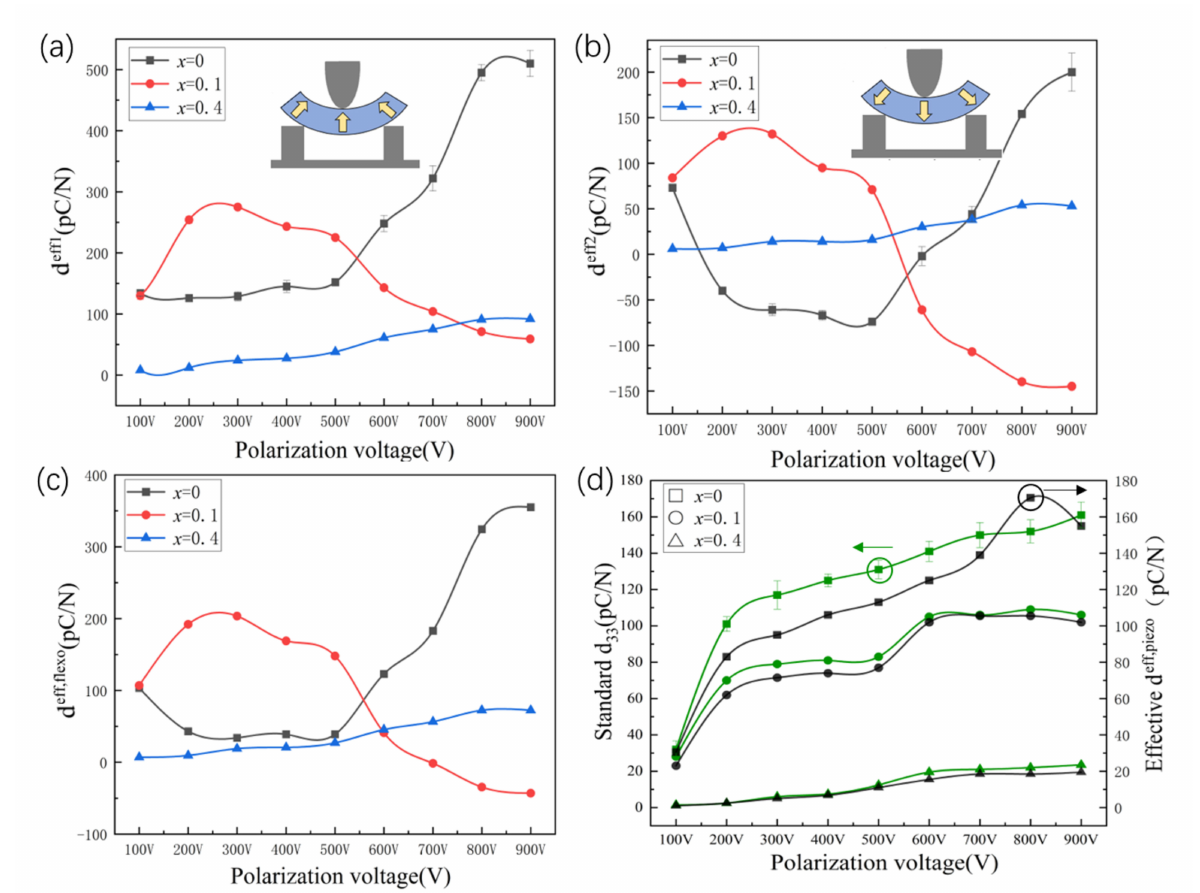
Figure 5. The apparent piezoelectric coefficient ( a ) d eff1 and ( b ) d eff2 of Ba 1 − x Ca x TiO 3 ( x = 0, 0.1, 0.4) ceramics poled at different voltages measured by the two-step point-ring method. The insets in ( a , b ) are schematic diagrams of the point-ring structure. The calculated ( c ) d eff,flexo and ( d ) d eff,piezo of the three samples. The standard piezoelectric coefficient d 33 measured by the standard quasi-static d 33 method is also shown in ( d